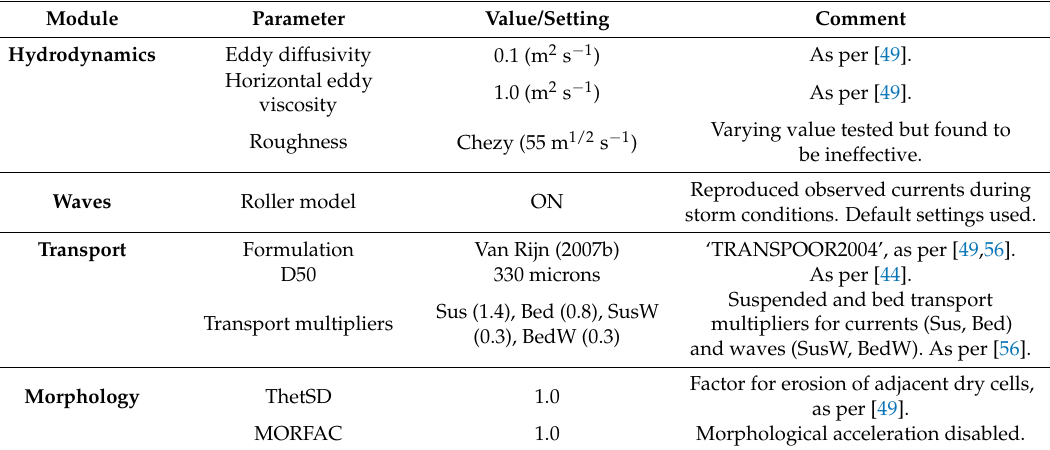
Table 1. Delft3D model